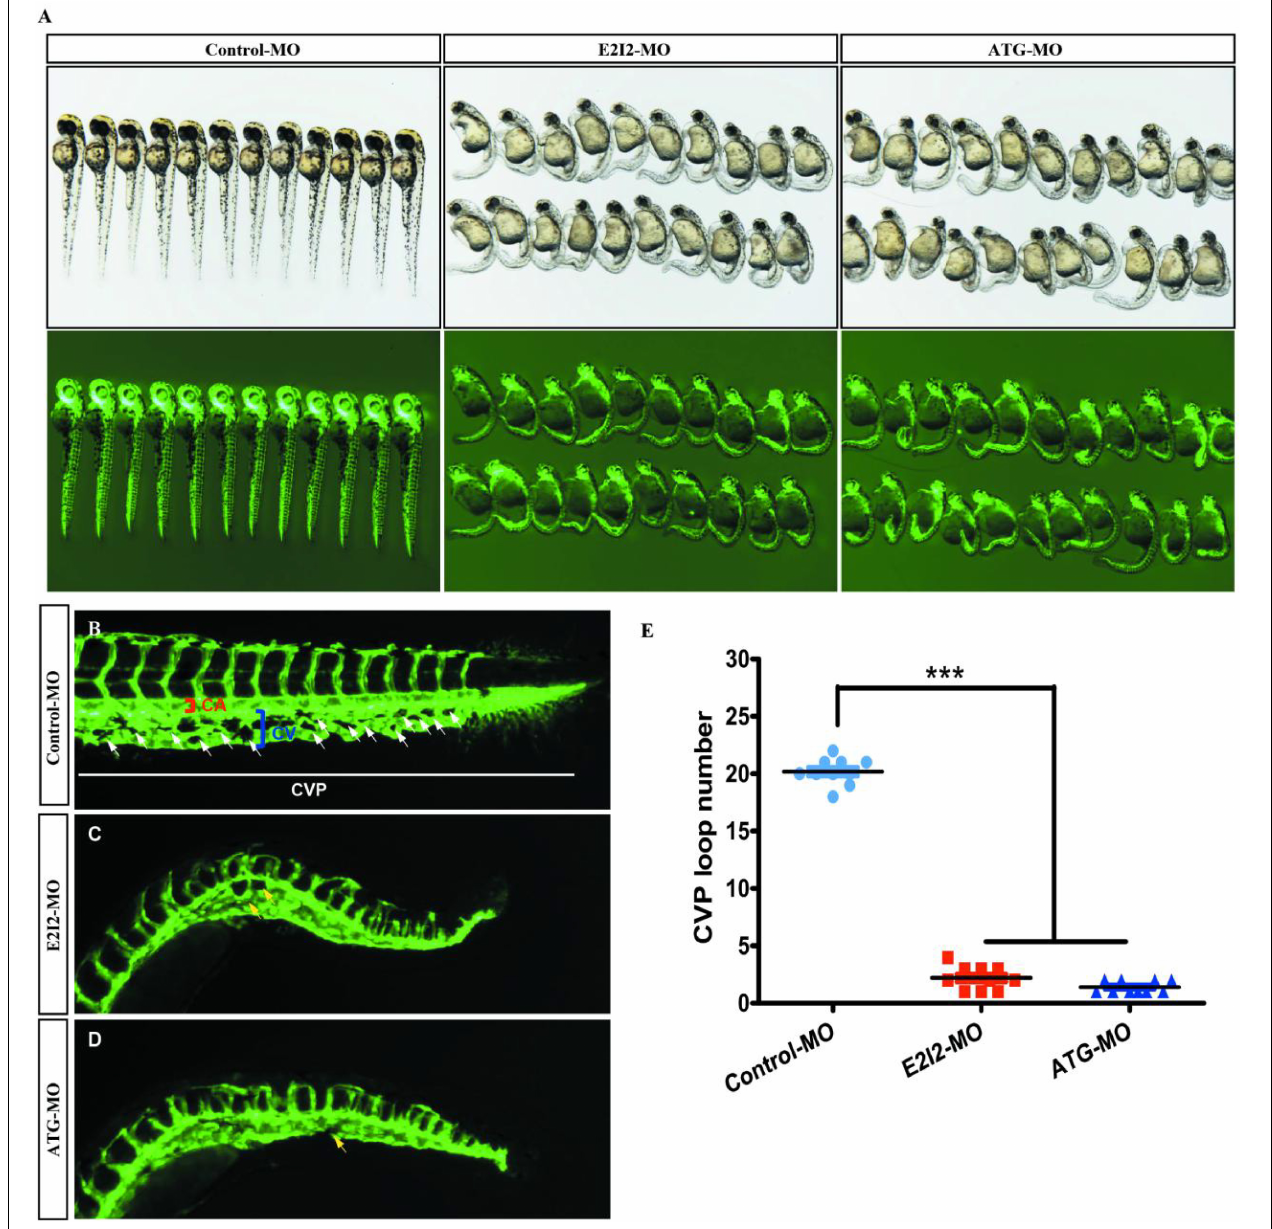
FIGURE 8 | Acta2 knockdown impairs formation of the CVP in zebrafish. (A) In control embryos, caudal vein plexus (CVP) were formed honeycomb-like structures at the tail around 50 h post-fertilization (hpf). (B–D) Acta2 knockdown resulted in specific defects in CVP formation. (E) Quantification of loop number at CVP. Columns, mean; SEM ( n = 10; ANOVA) * P < 0.05, ** P < 0.01, *** P < 0.0001. CVP, caudal vein plexus; CA, caudal artery; CV, caudal